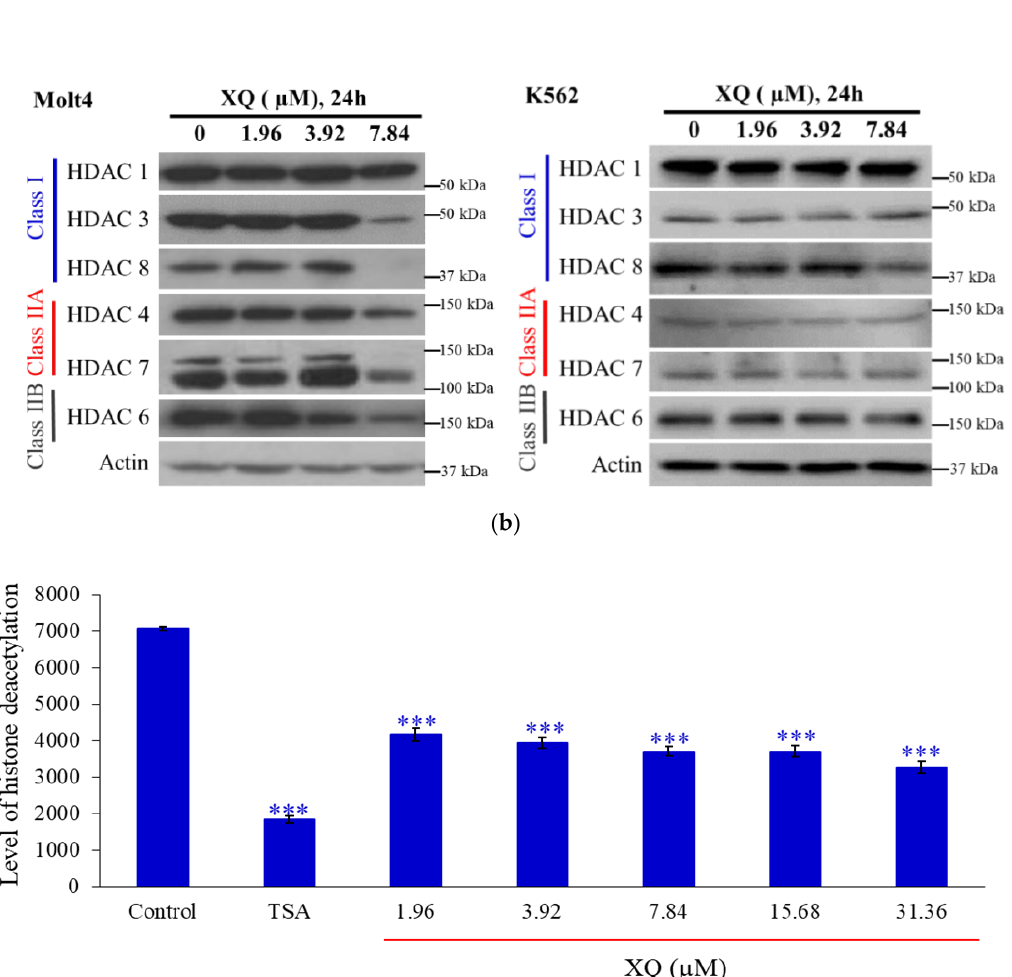
Figure 4. Xestoquinone inhibited HDACs’ expressions in human leukemia Molt-4 and K562 cells. Molt-4 and K562 cells were treated with XQ for 24 h and the whole-cell lysates were collected. ( a ) HDACs’ protein expressions were detected by Western blotting. ( b ) In the presence or absence of different doses of HDAC inhibitor XQ and TSA (positive control), a specific HDAC fluorescent substrate composed of acetylated lysine side chains is incubated with pan-HDAC enzyme before adding lysine Acid developer to detect pan-HDACs’ activity by ELISA. The results are presented as means ± SD of three independent experiments; *** p < 0.001. Actin was used as the loading control. 2.5. Xestoquinone Induced Cell Death in Human Leukemia Cells via Death Receptor Pathway and Apoptosis Xestoquinone treatment promoted the expression of several apoptotic markers in- cluding Annexin V externalization, PARP, caspases-3 and -7 in Molt4, K562, SupT1, and U937 leukemia cell lines (Figure 5a,b). XQ induced Fas and TRADD expressions after 1 h (Figure 5c). Moreover, the results showed that caspase-8 was activated after 6 h of drug